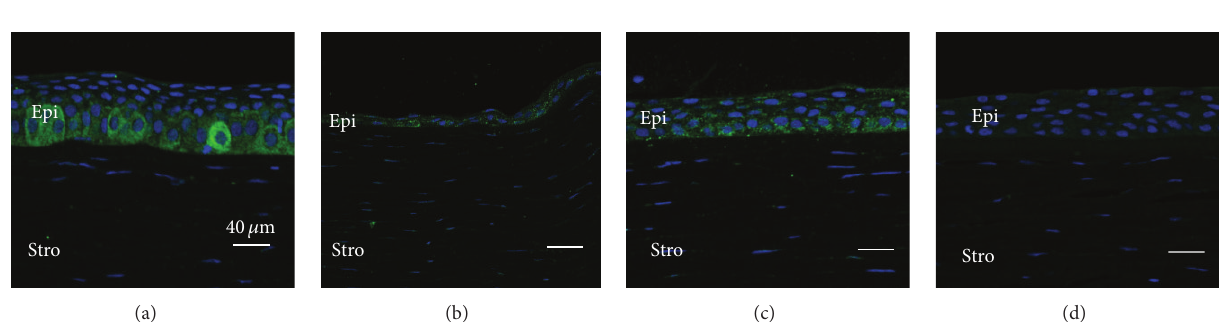
Figure 2: Representative images showing increased c-Met expression in basal epithelial cells adjacent to the cone region in KC (a), compared to the relatively more uniform expression seen in all layers of control cornea epithelium at a similar location (c). Weak c-Met staining is detected in the stroma in both KC and control corneas (a to c). No immunostaining is apparent in the Ig negative control (d). (a) Region adjacent to the cone in KC cornea, (b) cone region in KC cornea, (c) central region of control cornea, and (d) Ig negative control. Epi: epithelium; Stro: stromal. Green: HGF; blue: nuclei